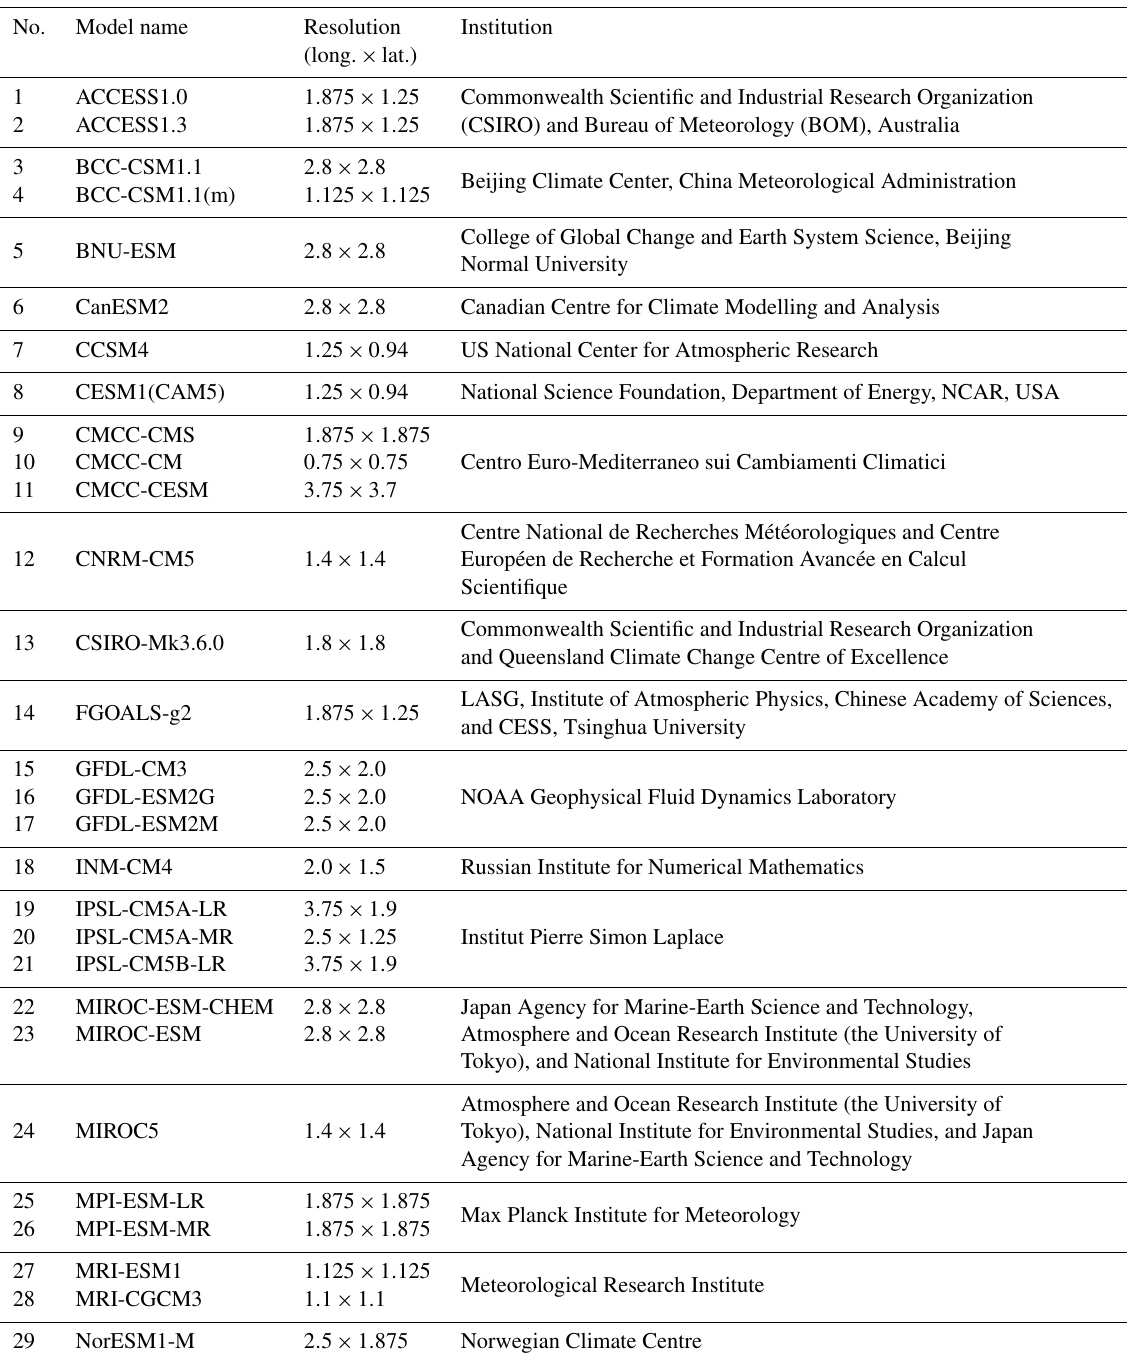
Table 1. Information about the 29 GCMs